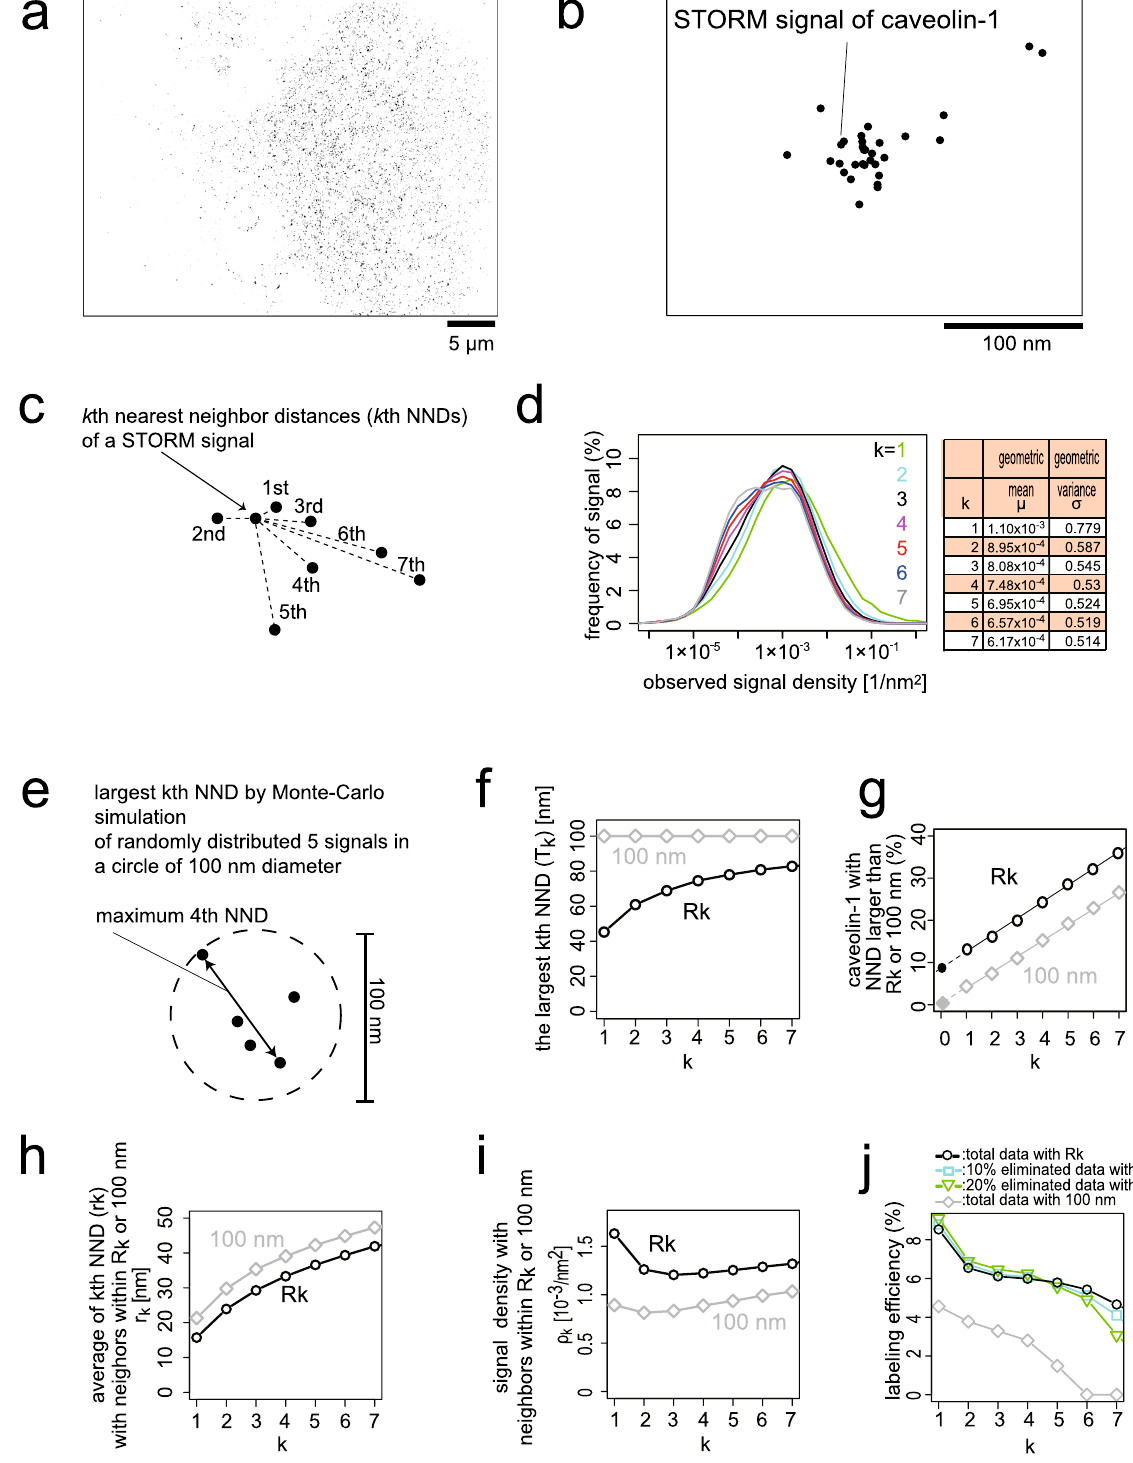
Figure 2. The k th nearest neighbouring distance (NND) measurement using a typical caveolin-1 observation from a cell. ( a , b ) Representative STORM images of a whole cell ( a ) and a caveola ( b ) with caveolin-1 staining obtained by indirect immunofluorescence with an anti-caveolin-1 antibody. Each dot corresponds to one STORM signal. ( c ) Schematic diagram of the k th NND for the signal density estimation of caveolin-1. ( d ) The representative density distributions of the STORM signals calculated from the k th NND in a cell under isotonic conditions, for k = 1–7 on a logarithmic scale. In the table, the geometric means ( μ ) and geometric variances ( σ ) are shown after fitting with a single log-normal distribution, because of their unimodal distribution. ( e ) A schematic diagram showing the maximum calculations of the 4 th NND using the 5 (4 + 1) signals generated by a Monte-Carlo simulation in a 100 nm diameter circle, determined from the typical diameter of a caveola. ( f